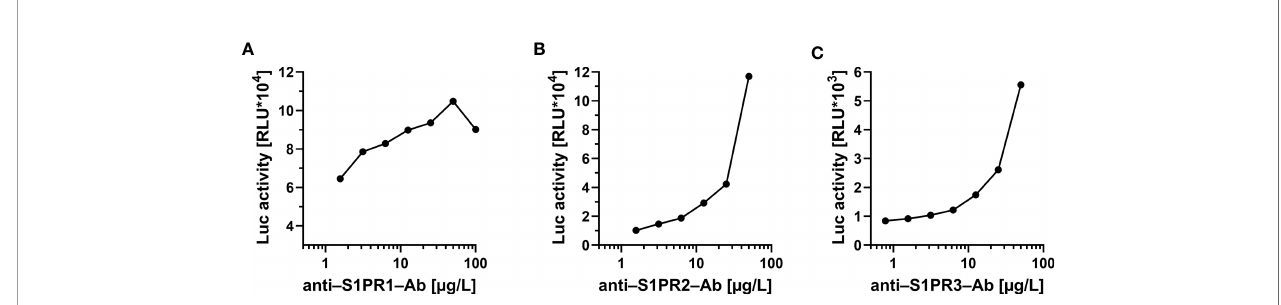
FIGURE 1 | Proof of concept for the novel tests to quantify commercial antibodies to the S1P-receptors. Signal development was tested with commercial antibodies to (A) S1PR1, (B) S1PR2 and (C) S1PR3, respectively. In all three newly developed detection assays, a concentration-dependent decline of signal intensity (expressed as relative light units; RLU) was observed in dilution experiments of commercial receptor-speci fi c antibodies. No cross-reactivity to other receptors was observed. Control measurements were conducted using either monoclonal (to S1PR1 and S1PR2) or polyclonal (to S1PR3)